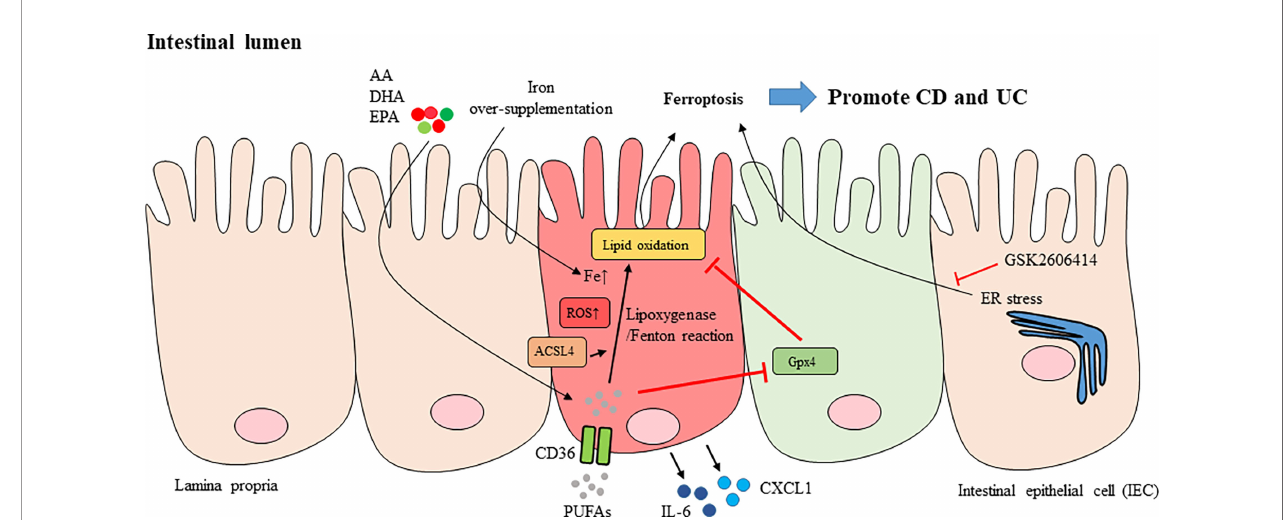
FIGURE 3 | Ferroptosis of intestinal epithelial cells in IBD. Over-supplementation of iron caused its deposition in the intestine and led to excessive production of ROS and intestinal in fl ammation (red IEC). AA, EPA and DHA listed here are part of PUFAs. PUFAs whose uptake is mediated by CD36 are the major substrates for lipid peroxidation. The oxidation of PUFAs can be regulated by either lipoxygenase-mediated reaction, or Fenton-type reaction, in the plasma membrane. ACSL4 that esteri fi es AA into phospholipids facilitated peroxidation. Oxidation of PUFAs induced pro-in fl ammatory cytokines or mediators like IL-6, CXCL1 production in IEC as well as lipid peroxidation and ferroptosis of IECs. The expression and enzymatic activity of Gpx4 prevents lipid peroxidation in IEC (green IEC). The ER stress was also shown to be mediating IEC ferroptosis and suppression of ER stress with GSK2606414 inhibited ferroptosis of IECs. CD, Crohn ’ s disease; UC, ulcerative colitis; IEC, intestinal epithelial cell; PUFAs, polyunsaturated fatty acids; AA: arachidonic acid; EPA, eicosapentaenoic acid; DHA, docosahexaenoic acid; GSH, glutathione; Gpx4, glutathione peroxidase 4; ACSL4, acyl coenzyme A synthetase long chain 4; ER, endoplasmic reticulum; IL-6, interleukin-6; CXCL1, chemokine (C-X-C motif) ligand